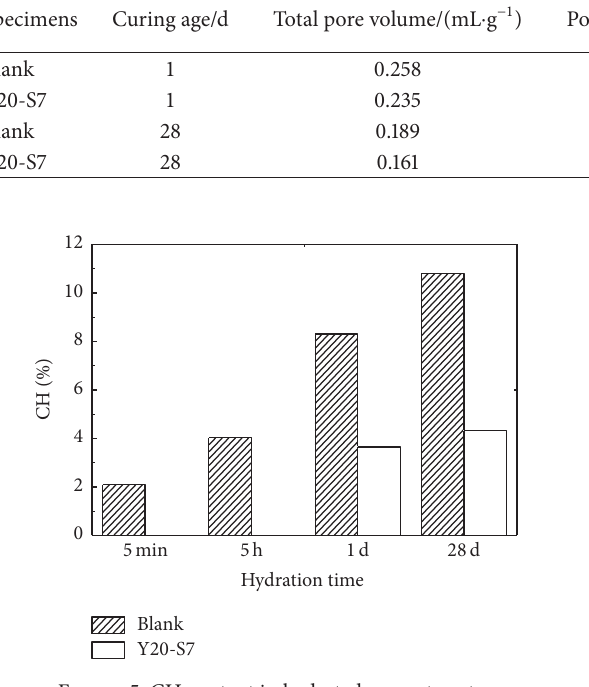
Figure 5: CH content in hydrated cement